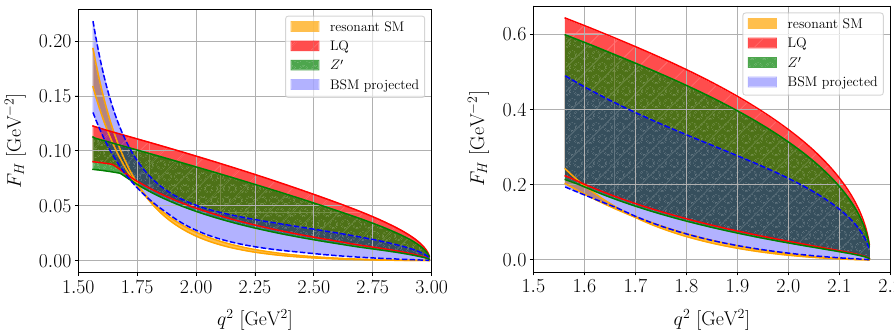
Fig. 8 F H in D + → π + μ + μ − (plottotheleft)and D + s → K + μ + μ − in concordance with kaon and high p T -data and RG-effects, see text for details. The lilac bands illustrate the impact of a less maximal (plot to the right) decays in the high– q 2 region in the SM (thin yellow BSM scenario from leptoquarks, or in Z (cid:3) -models, with C 9 + C (cid:3) band). Also shown are maximal effects in a Z (cid:3) -model (green bands) for − ( C = − ( C + C (cid:3) ) = 0 . 63 and a leptoquark scenario (red bands) + C (cid:3) ) = 0 . C 9 + C (cid:3) 10 10 9 10 10 = − C (cid:3) = 0 . 63, C = C = 11 C = 11 C = − 0 . 0056, with C (cid:3) S P T T 5 9 10